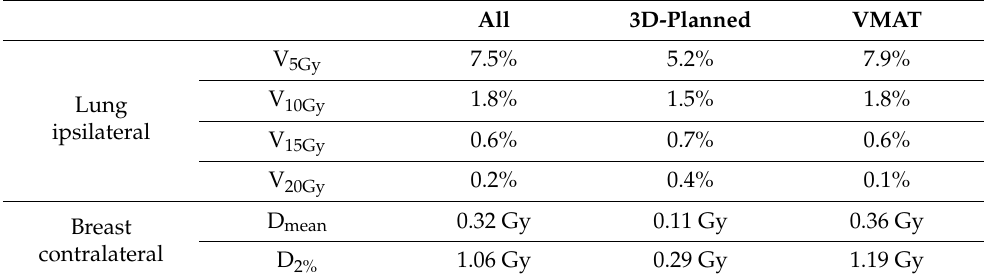
Table 2. Very low radiation doses were shown for the ipsilateral lung and contralateral breast.